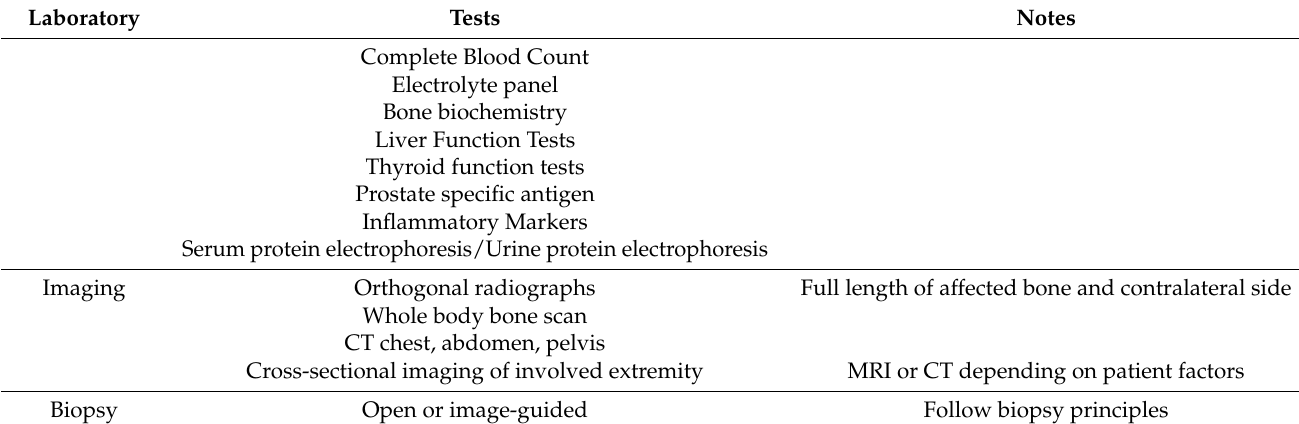
Table 1. Workup for unknown bone lesion in patients >40 years old.